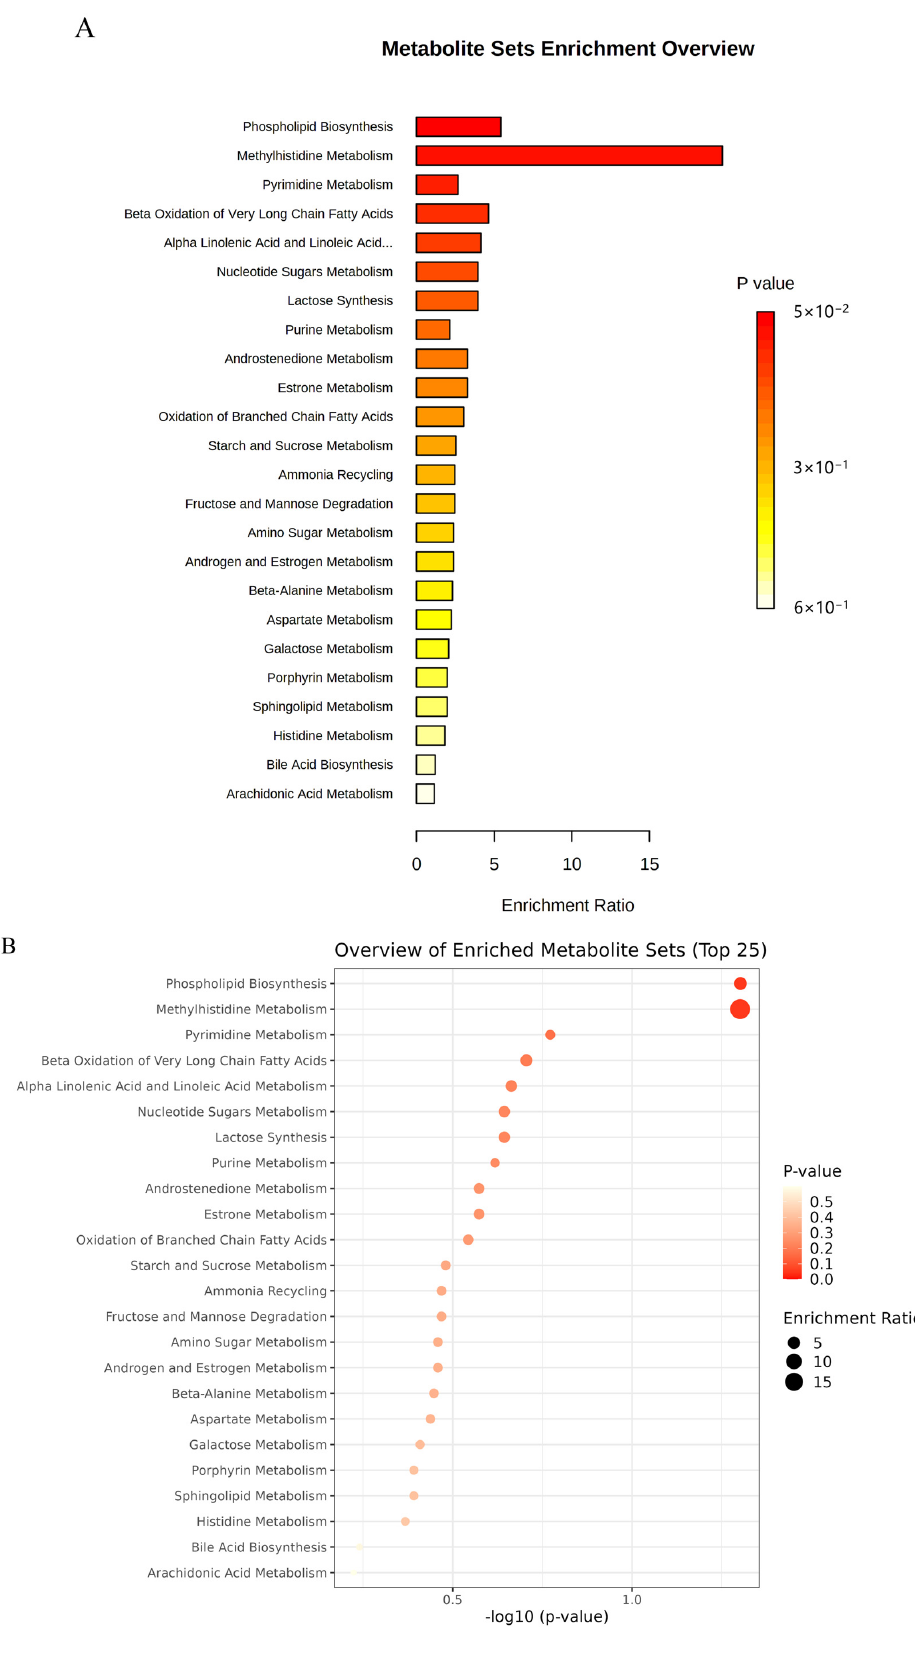
Figure 9. Metabolic pathway enrichment analysis of differential metabolites conducted based on the Kyoto Encyclopedia of Genes and Genomes (KEGG) database. ( A ) Bar chart and ( B ) Bubble chart. Table 2. Statistical analysis results of the main metabolites in 4T1 cells.